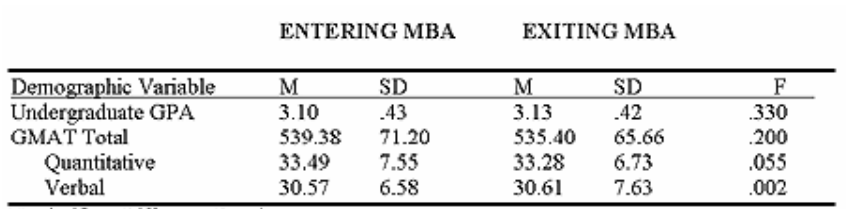
Table 1. Analysis of variance of GMAT and undergraduate GPA by